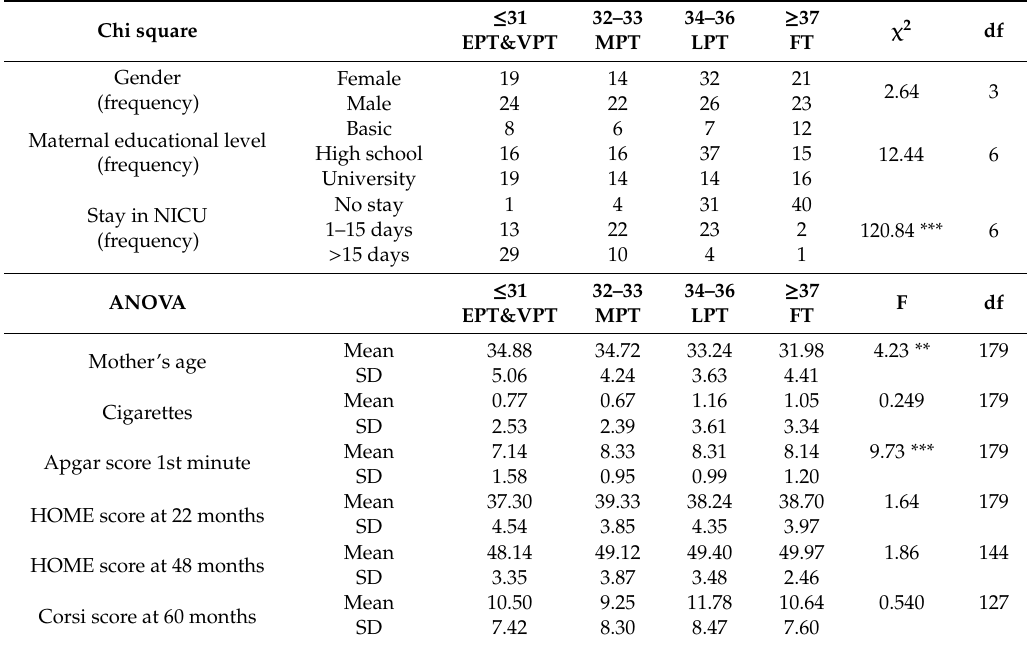
Table 1. Descriptive data and comparisons among the 4 GA groups a